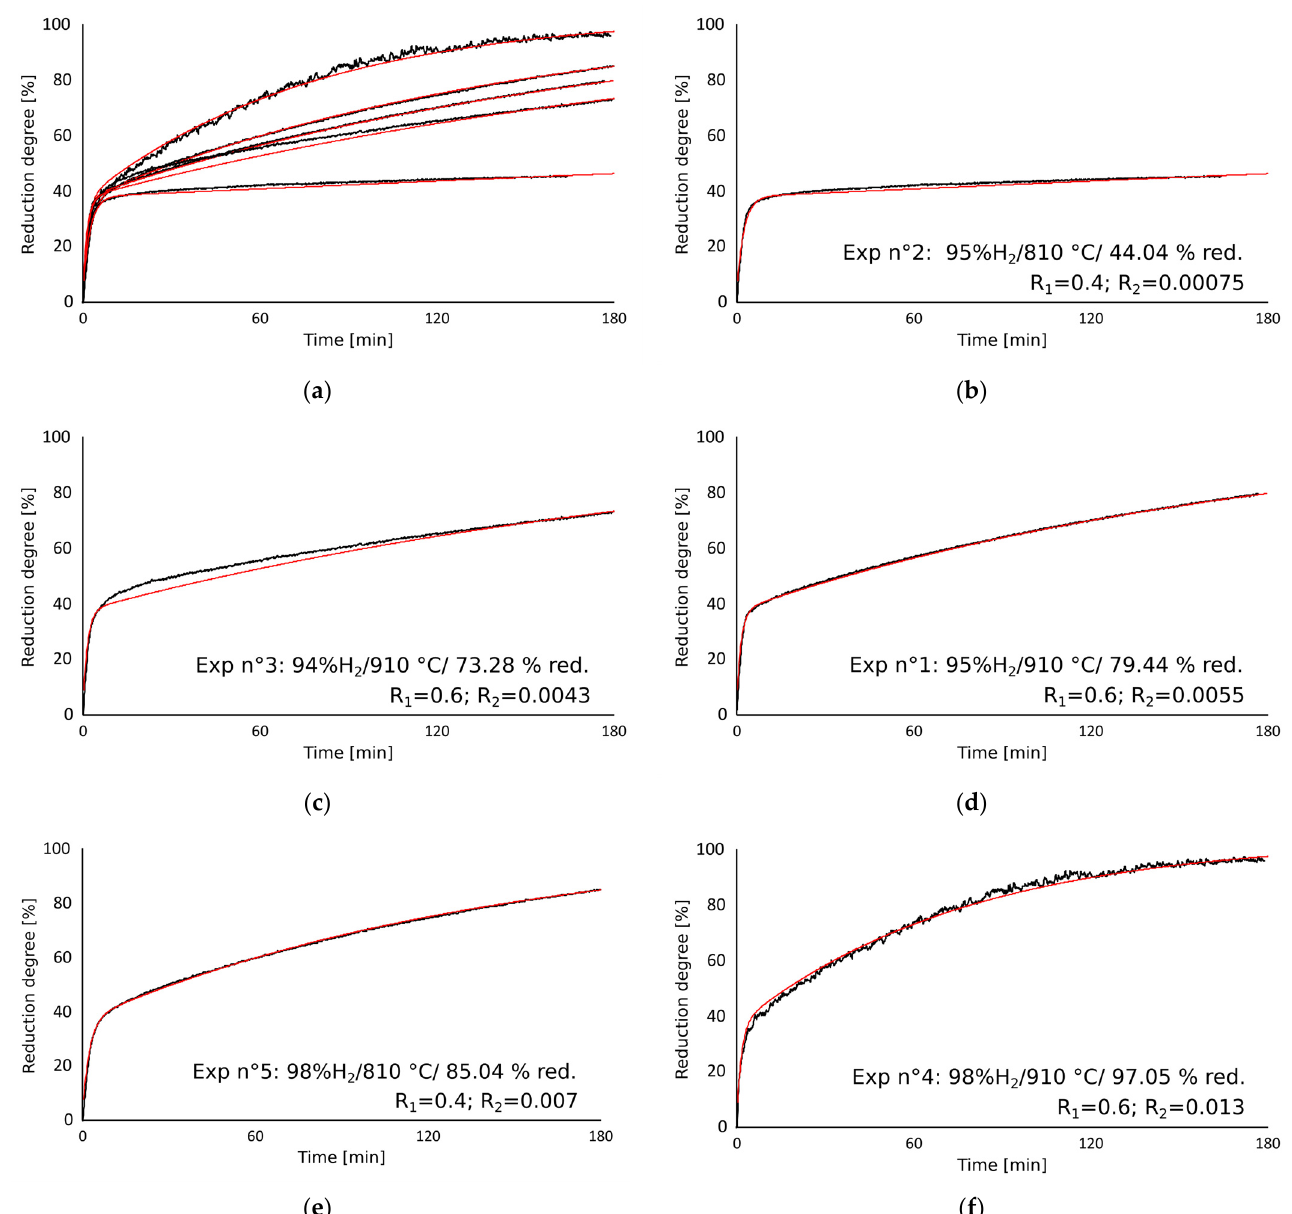
Figure 10. Reduction degree as a function of time according to (in black) the experimental measure- ment and (in red) the model. ( a ) All the following curves are shown together; ( b ) experiment at 810 °C and 95%H 2 ; ( c ) experiment at 910 °C and 94%H 2 ; ( d ) experiment at 910 °C and 95%H 2 ; ( e ) exper- iment at 810 °C and 98%H 2 ; ( f ) experiment at 910 °C and 98%H 2.